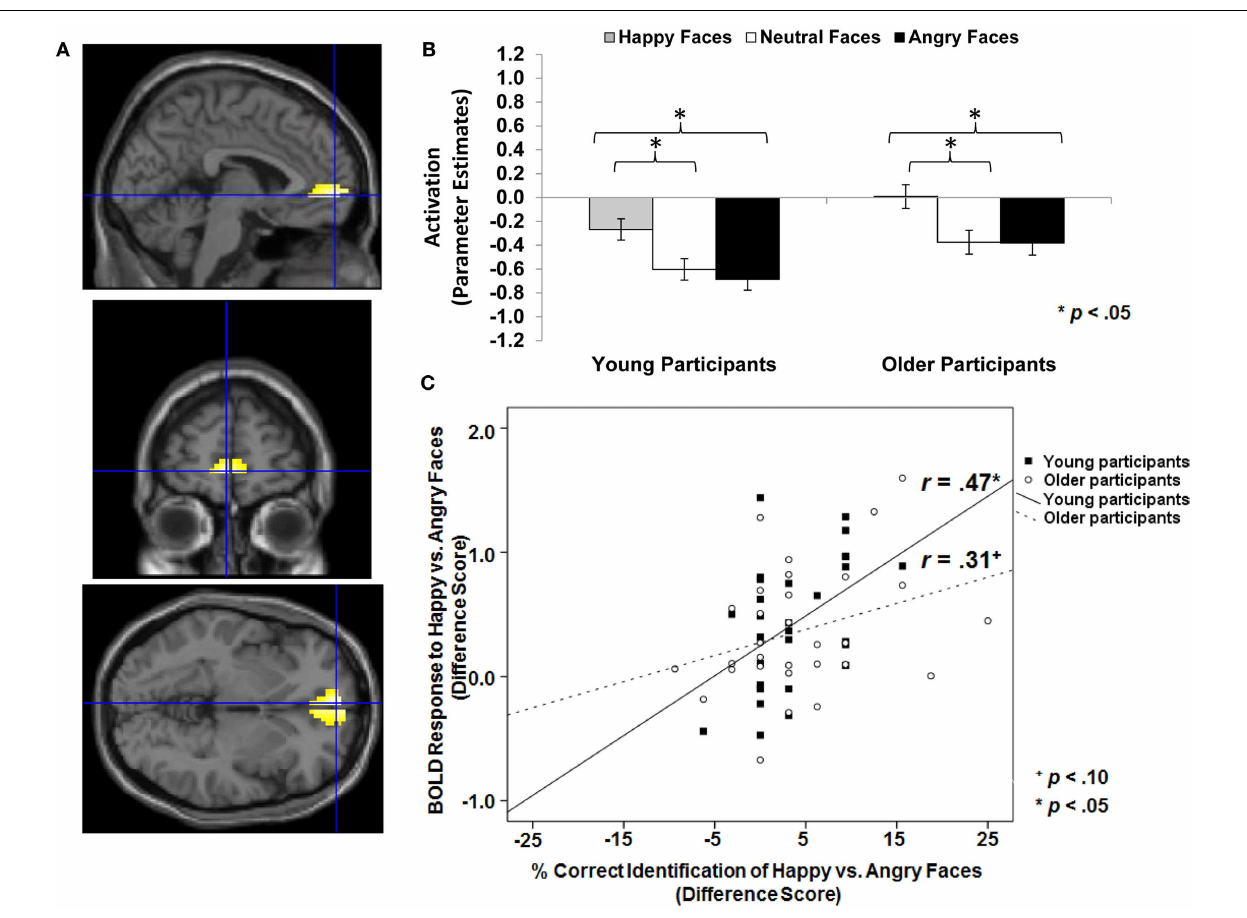
age of face); betas for this region of activation identified by the T -contrast happy faces > angry faces were extracted for each individual from a 5-mm sphere around the local maximum within the region of activation and averaged to produce a single value for each condition of interest, respectively. (C) Mean difference in participants’ left vmPFC BOLD response to happy relative to angry faces in relation to the percentage of correctly identified happy relative to angry faces for young and older participants,